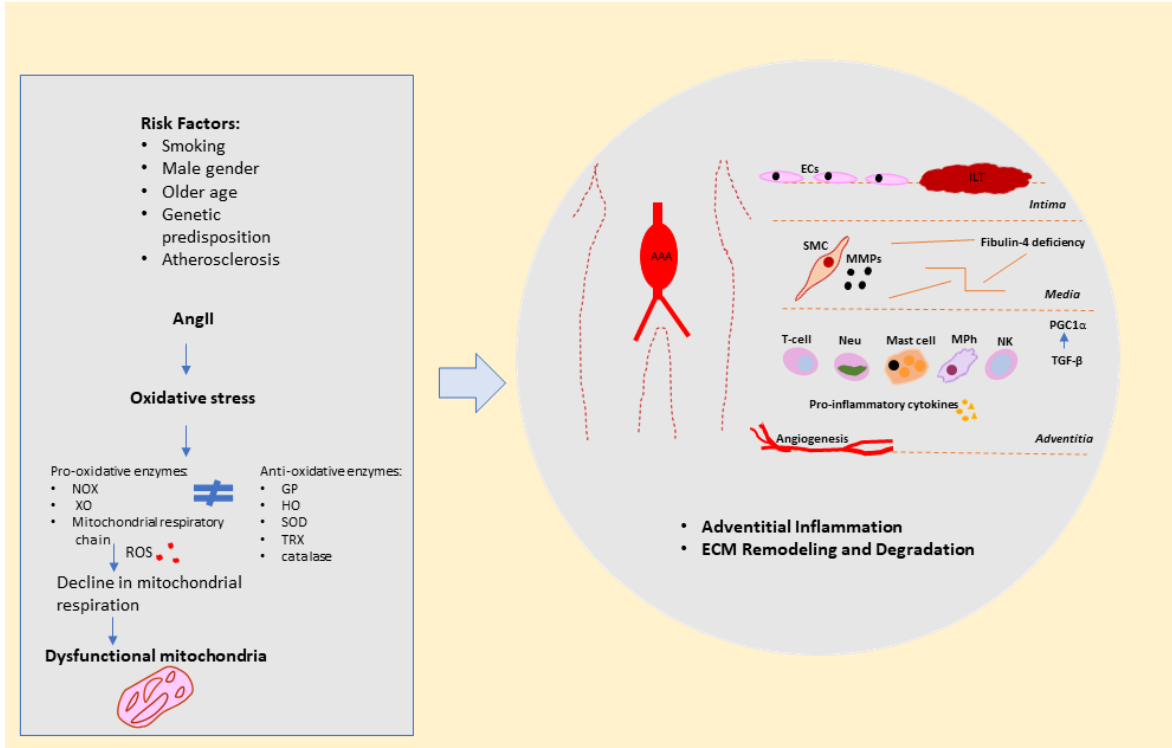
Figure 1: Schematic representation of biological processes involved in AAA